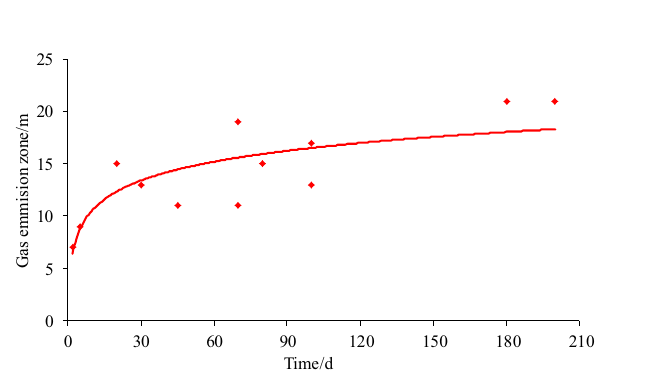
Table 6. The width of gas emission zone corresponding to coal seam gas content at different time.